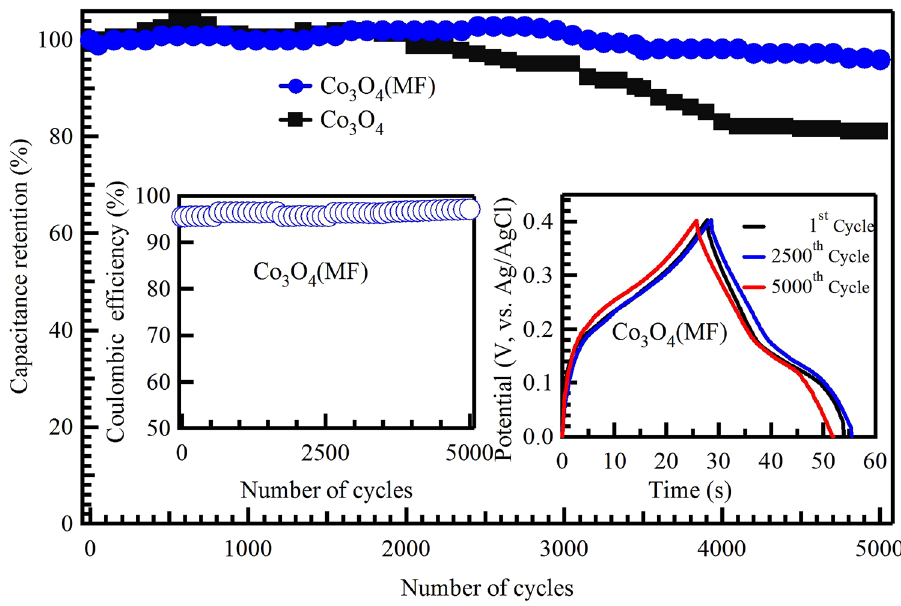
Figure 32: Capacitance retention ( stability ) for Co 3 O 4 ( MF ) compared with Co 3 O 4 . The Coulombic e ffi ciency and some GCD cycles are shown in the insets. Copied with permission from ref. [ 391 ] ; American Chemical Society,